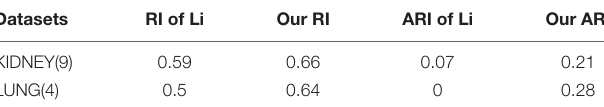
TABLE 5 | Rand index (RI) and adjusted Rand index (ARI) on two datasets between Li’s and our